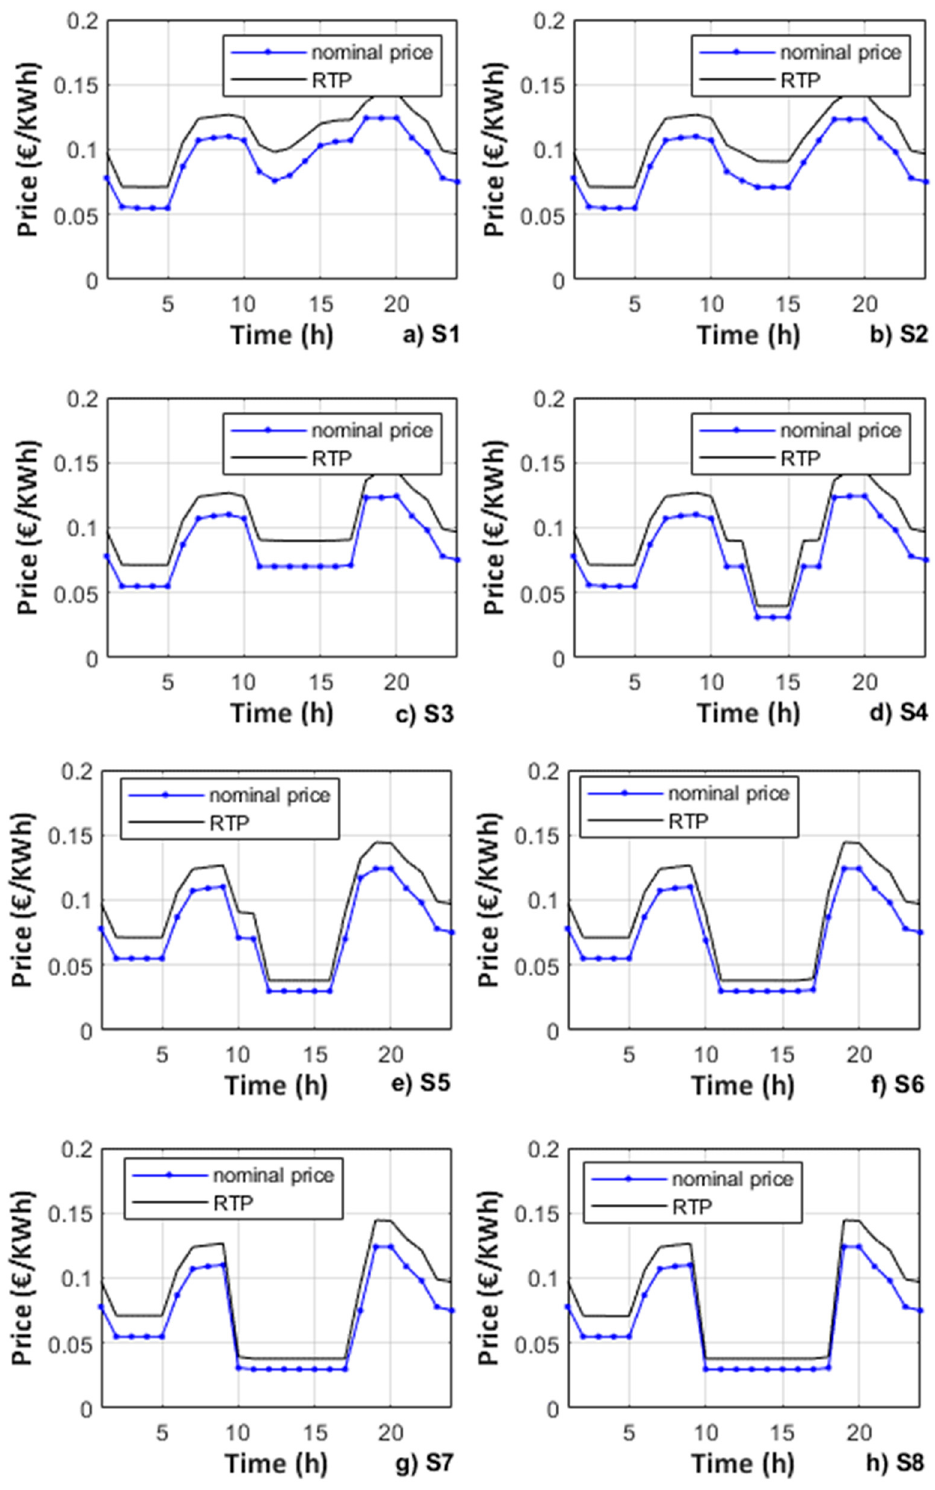
Figure 7. Nominal price and RTP corresponding to day 9 October 2019 for: ( a ) S1, ( b ) S2, ( c ) S3, ( d ) S4, ( e ) S5, ( f ) S6, ( g ) S7, and ( h ) S8. (source: Authors).